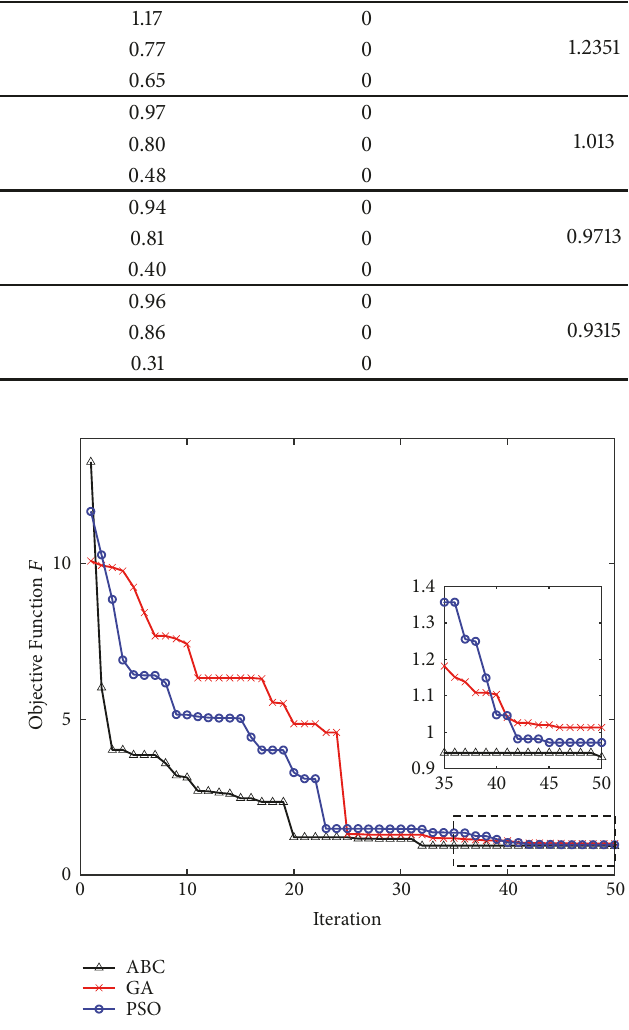
Figure 6: Evolutionary curves of the three